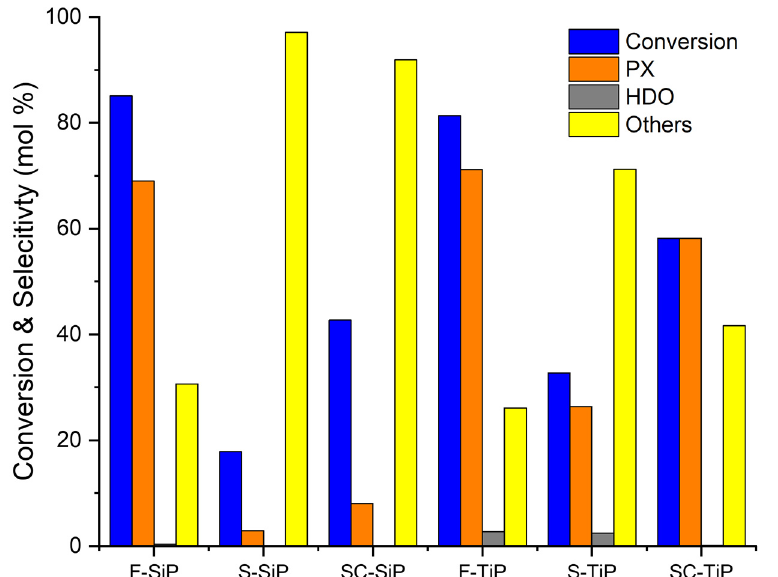
Figure 7. Conversion of DMF and selectivity of PX and HDO for the Diels–Alder reaction of DMF and ethylene for stability test over phosphated catalysts at 773 K calcined. F: Fresh, S: Spent, SC: Spent Calcined. Reaction condition; temperature = 523 K, reaction time = 6 h, C 2 H 4 pressure = 30 bar, DMF = 11.1 wt. %, catalyst mass = 300 ± 5 mg.